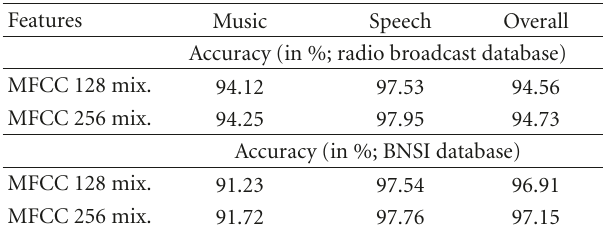
Figure 7: Histogram of speech/music segmentation time-error analysis. Table 7: Segmentation performance of MFCC features, performed on BNSI and radio broadcast